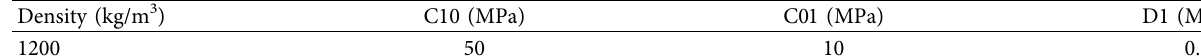
Figure 19: Diagram of the optimization of the pipeline structure. (a) Option 1. (b) Option Table 3: Parameters of the damping material.